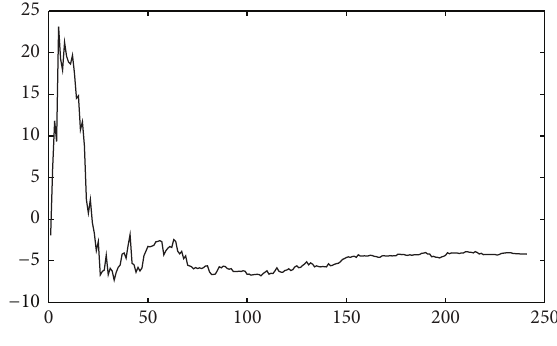
Figure 1: Values of 𝑓(𝑡) during Asian crisis.